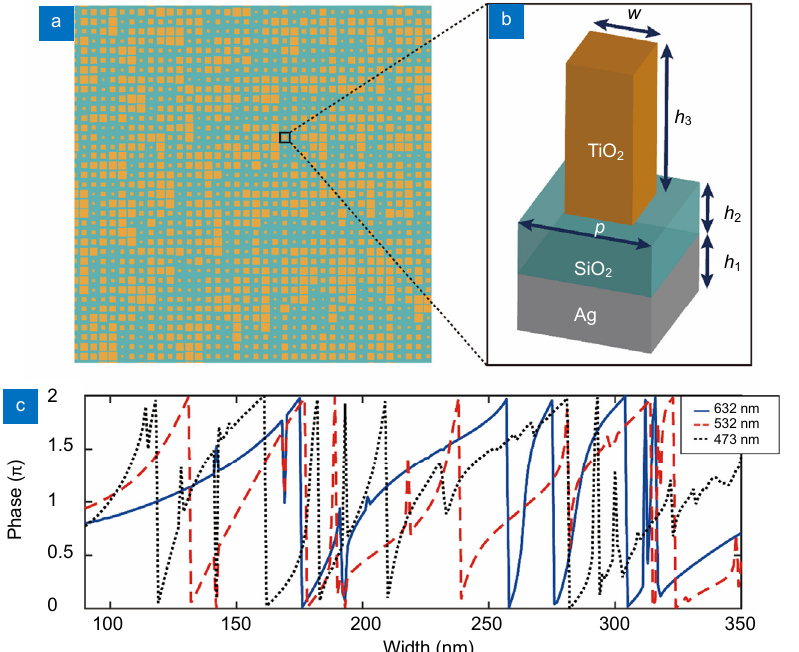
Fig. 2 | ( a ) Top-view of part of the designed metalens. ( b ) The element consists of a titanium dioxide (TiO 2 ) nanopillar ( h 3 =530 nm) on top of a silicon dioxide (SiO 2 ) layer ( h 2 =180 nm) above a silver substrate ( h 1 =200 nm). The period p =400 nm, the nanopillar has a square cross-section with width w . By adjusting the width, the reflection phase can be controlled. ( c ) Numerically calculated reflection phase shift as a function of w at three wavelengths of 473 nm, 532 nm, and 632 nm. As the nanopillar width w changes from 90 nm to 350 nm, the corresponding phase undergoes multiple 0–2 π phase cycles. The refractive indexes of TiO 2 are 2.493, 2.43 and 2.373 for 473 nm, 532 nm, and 632 nm in the simu- lations,